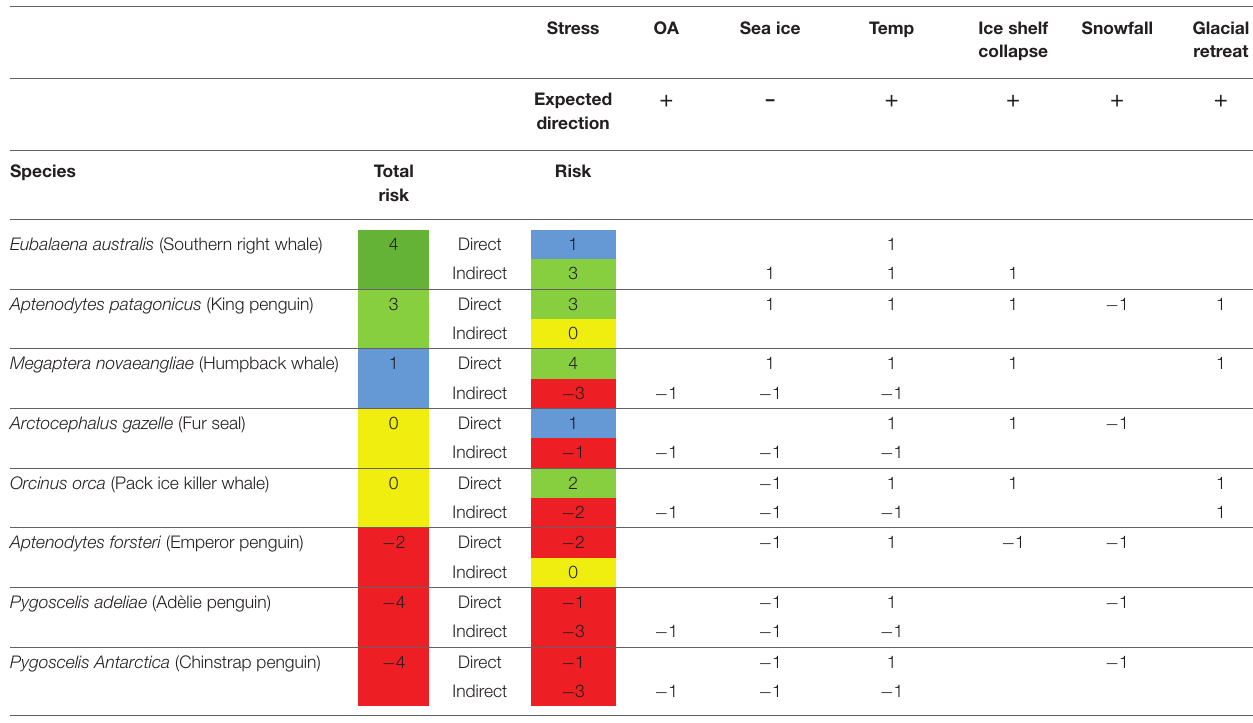
TABLE 5 | Risk assessment matrix for marine